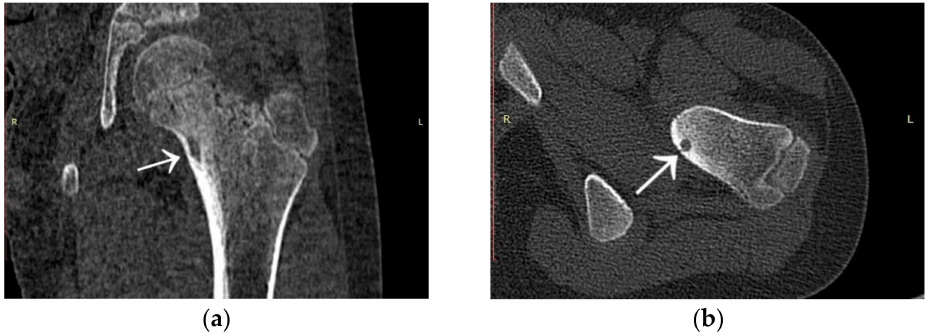
Figure 15. CT scans showing a focus of OO (arrows) in the left femoral neck. ( a ) Frontal CT scan; ( b ) Transverse CT